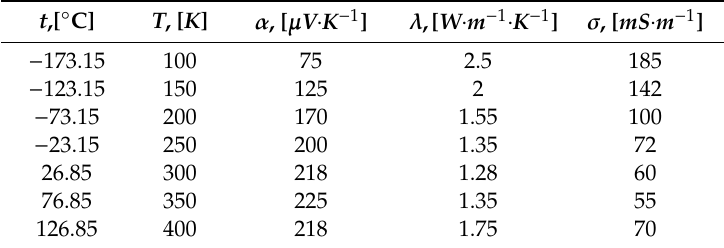
Figure 16. Transient calculation of Peltier-supercooling. A short current pulse (upper magenta line) generates temporarily lower cold side temperatures. The gray solid line demonstrates results of the finite element simulation from [33], the dashed line corresponds to a simulation by the proposed method.